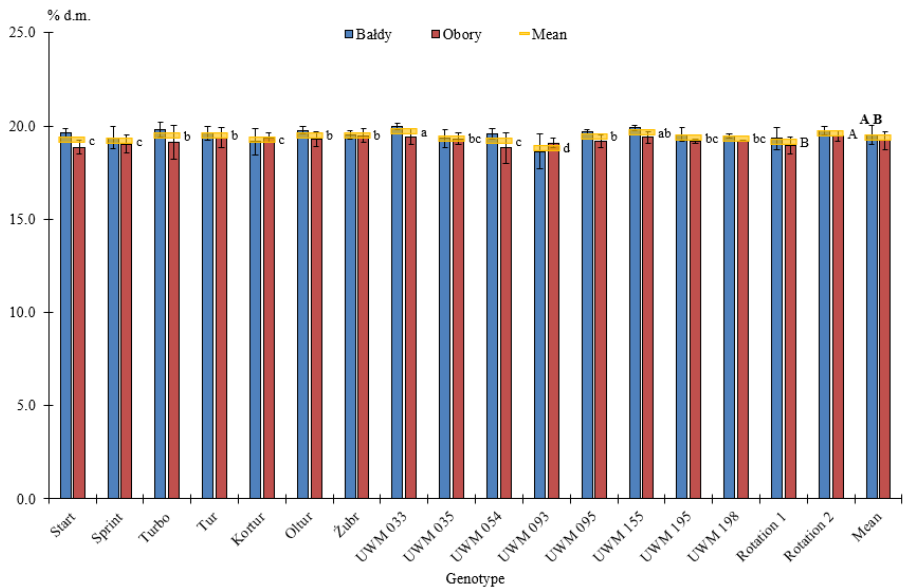
Figure 3. Fixed carbon content in the biomass of 15 willow genotypes obtained at two locations in two consecutive three-year harvest rotations; (legend: see Figure 1).